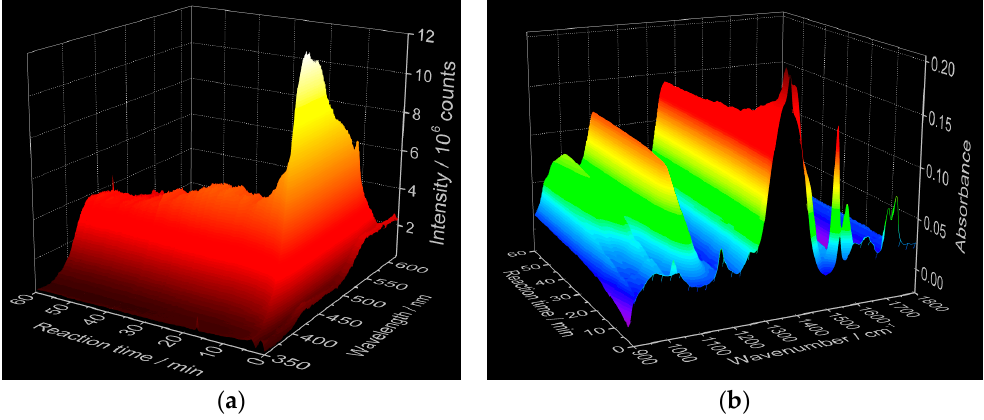
Figure 3. ( a ) In situ luminescence and ( b ) infrared spectroscopic analysis during the crystallization of Al(acac) 3 (35 °C, concentration of NH 3 25%).